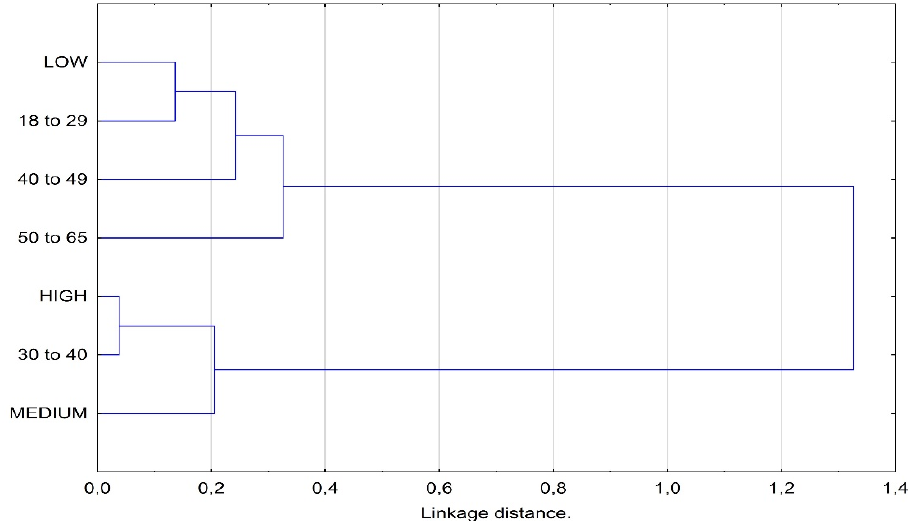
Figure 2. Dendrogram showing clustering of the analyzed categories.